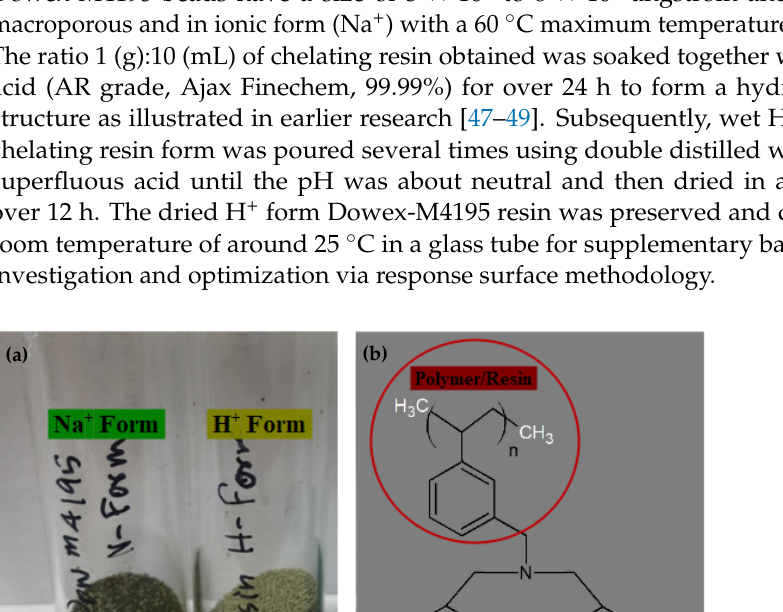
Figure 15. Desirability ramps of Cu(II) removal efficiency onto H + Dowex-M4195 chelating resin from the selected quadratic model at a low pH.